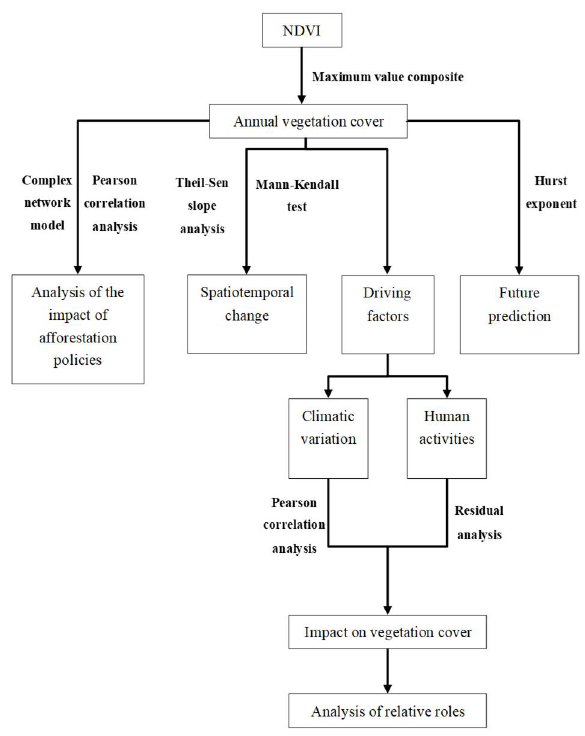
Figure 2. Flowchart of the research